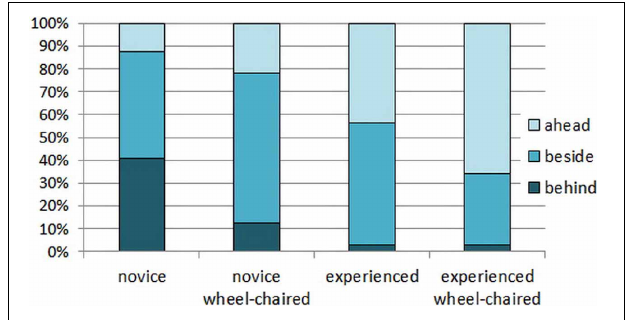
FIGURE 3 | The schematic drawing of test situation in Study 2/Test 1, showing the position of the participants and the place of the basket in different